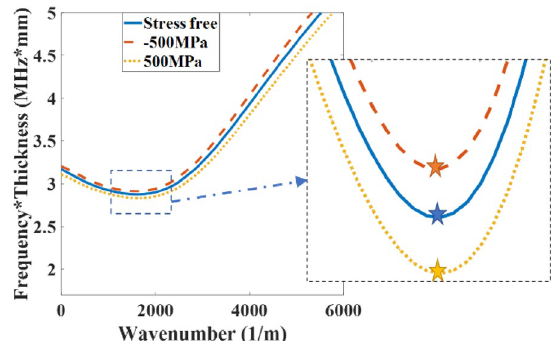
Figure 5 Dispersion curves of S1 mode under different uniform stresses (The stars denote the S1-ZGV mode at stress-free, compressive 500 MPa, and tensile 500 MPa, respectively)